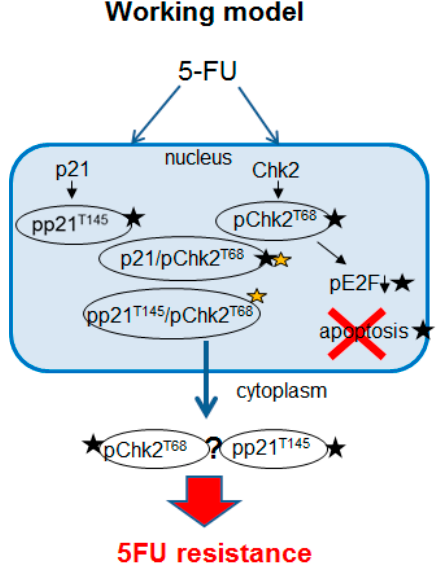
Figure 8. Schematic model of p21/Chk2-mediated 5FU resistance. Black stars mark where experimental evidence is given, and orange star marks in silico analysis. The fate of p-Chk2 in the cytoplasm after detachment of the complex is unclear.